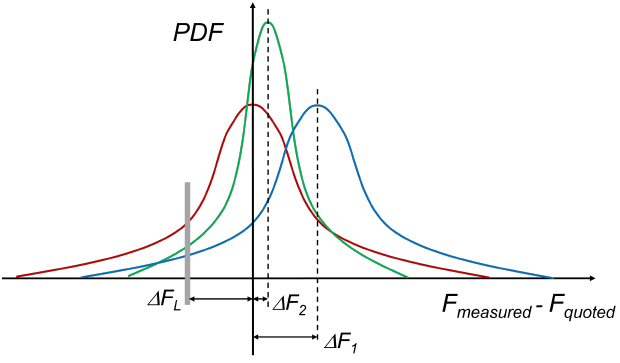
Figure 6. Effect of uncertainty on quoted performance. The red line corresponds to an uncertain parameter with no saftety margin and high probability of failing performance standards. The blue line shows the same uncertain parameter with a large saftey margin ∆ F 1 required to reduce failure probability to an acceptable level. The green line shows how the safety margin ∆ F 2 achieving same failure probability can be reduced by reducing the overall